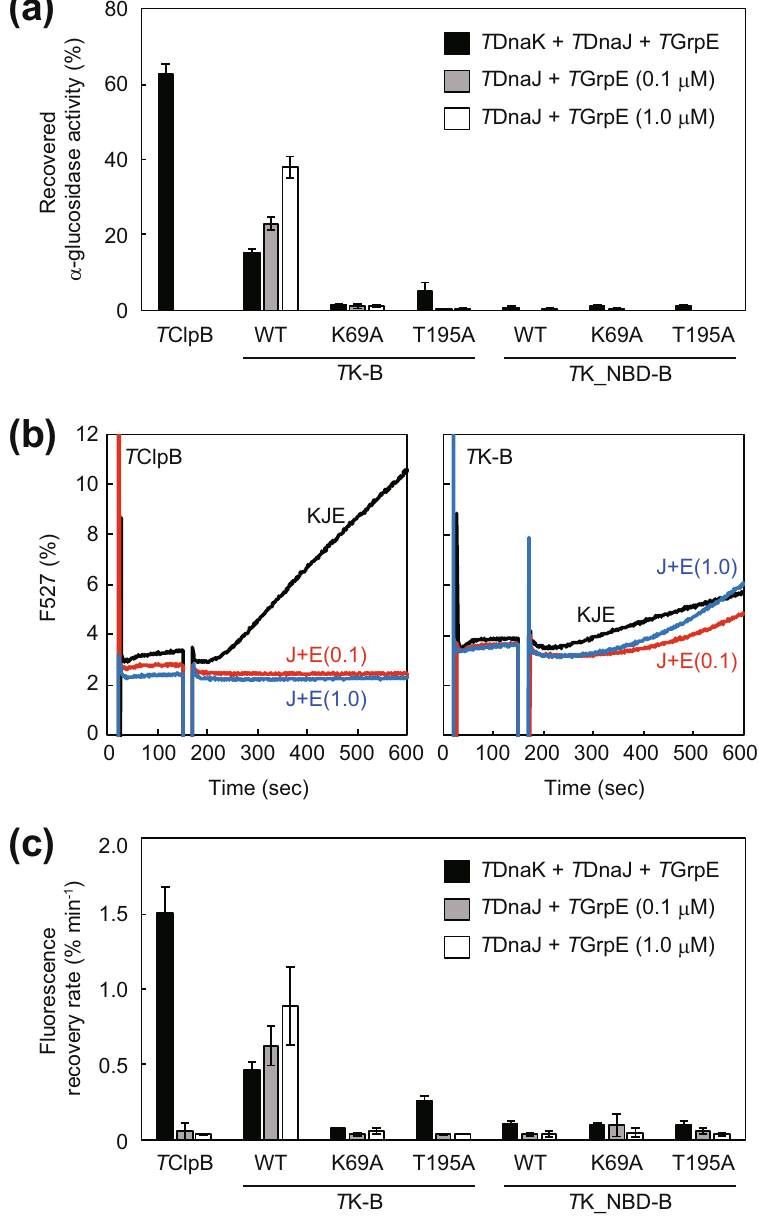
Figure 3. Disaggregation activities of fusion proteins. ( a ) Heat-aggregated α -glucosidase (0.2 μ M) from moderate therrmophilic bacteria was incubated with T DnaK (0.6 μ M), T DnaJ (0.2 μ M), and T GrpE (0.1 μ M dimer) (termed T KJE), and the indicated T ClpB or fusion proteins (0.05 μ M hexamer) at 55 °C for 90 min in the presence of 5 mM ATP (black bar). After the incubation, the recovered enzymatic activity was measured and is shown as a percentage of the activity prior to heat aggregation. T DnaJ (0.2 μ M) with T GrpE (0.1 μ M dimer) (termed T JE0.1) (gray bar) or T DnaJ (0.2 μ M) with T GrpE (1.0 μ M dimer) (termed T JE1.0) (open bar) were also used instead of T KJE. ( b ) Heat-aggregated EYFP (0.3 μ M) was incubated with chaperones at 55 °C in the presence of 5 mM ATP, and the fluorescence at 527 nm (excitation 513 nm) was monitored. T ClpB (left panel) and T K-B (right panel) were used. T KJE (black line), T JE0.1 (red line), or T JE1.0 (blue line) was also added. Fluorescence intensities are shown as a percentage of that prior to heat aggregation. ( c ) Initial rates (except for the lag times if existing) for the fluorescence recovery of EYFP were calculated from the measurement of ( b ) and the same experiments using T K-B, T K_NBD-B, and their mutants. Error bars represent standard deviations of three or more independent measurements. WT,